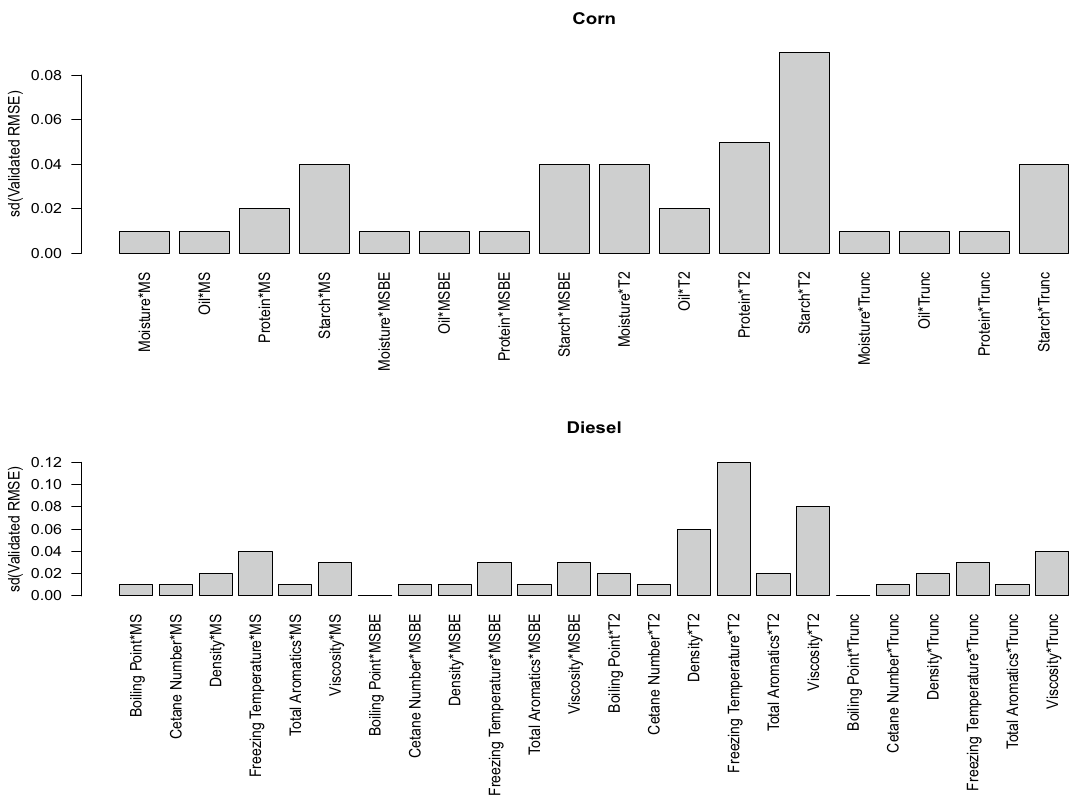
Figure 5. The standard deviations of validated RMSE for all fitted models of corn and diesel contents are presented. Moisture Oil Protein Starch Factor Level Estimate P-value Estimate P-value Estimate P-value Estimate P-value Intercept 0.007 < 0.001